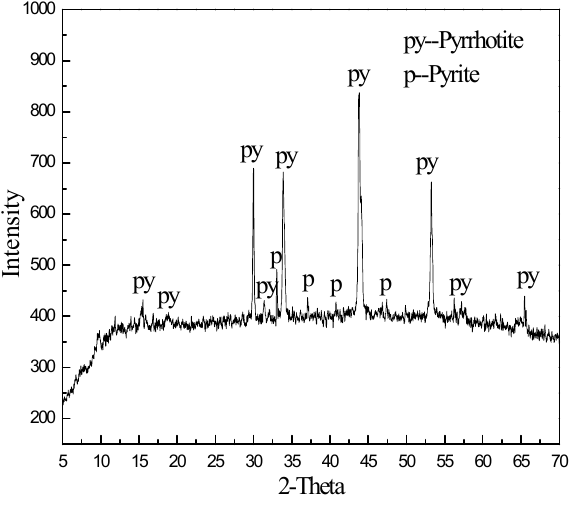
Figure 1. X-ray diffraction (XRD) pattern of the pyrrhotite sample. Table 1. Chemical compositions of chlorite.